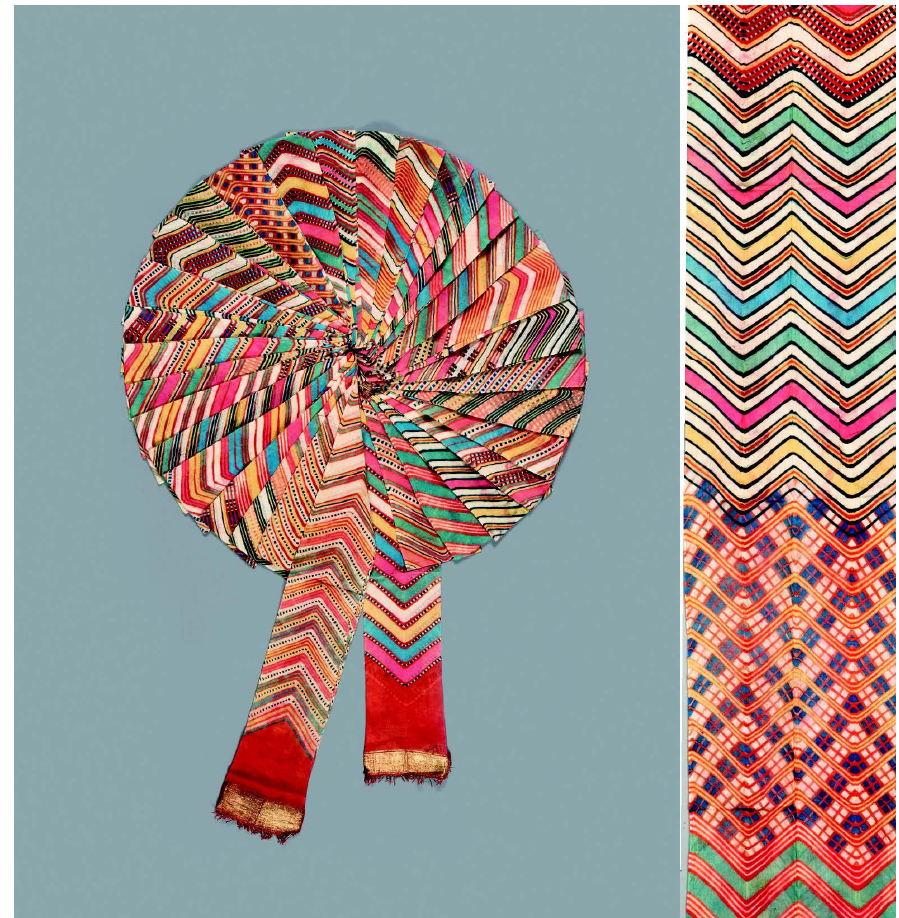
Figure 6 Figure 6. Tie-Dyed Lahariy¯a turban cloth, Tie-dyed cotton. India (Rajasthan), c.